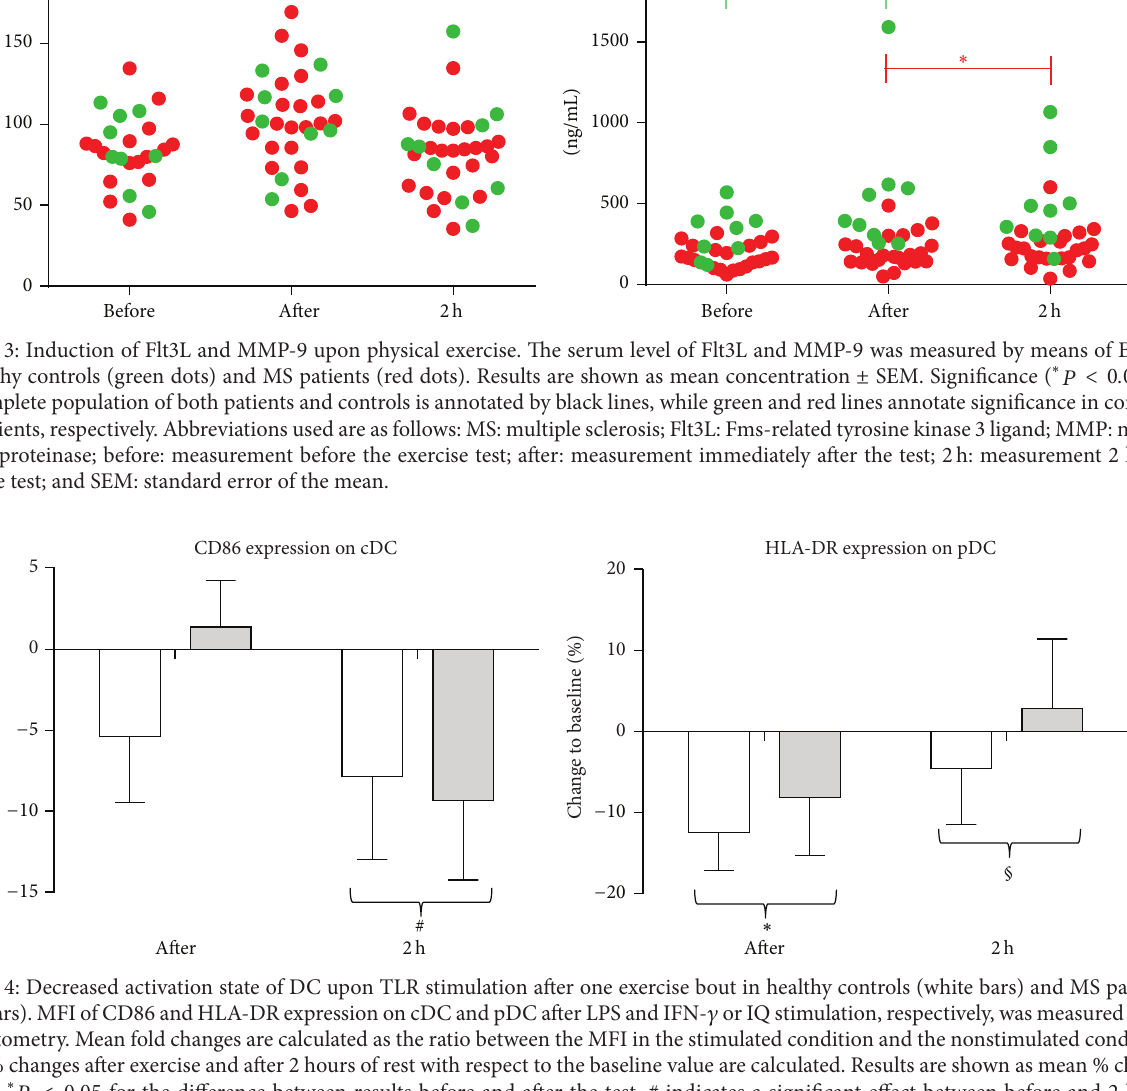
§ ∗ 2 h Figure 4: Decreased activation state of DC upon TLR stimulation after one exercise bout in healthy controls (white bars) and MS patients (grey bars). MFI of CD86 and HLA-DR expression on cDC and pDC after LPS and IFN- 𝛾 or IQ stimulation, respectively, was measured using flow cytometry. Mean fold changes are calculated as the ratio between the MFI in the stimulated condition and the nonstimulated condition. Then, % changes after exercise and after 2 hours of rest with respect to the baseline value are calculated. Results are shown as mean % change ± SEM. ∗ 𝑃 < 0.05 for the difference between results before and after the test. # indicates a significant effect between before and 2 hours after the test. § indicates a significant effect between after and 2 hours after the test. Abbreviations used are as follows: cDC: conventional dendritic cells; pDC: plasmacytoid dendritic cells; LPS: lipopolysaccharide; IFN: interferon; IQ: imiquimod; HLA: human leukocyte antigen; MFI: mean fluorescence intensity; after: measurement immediately after the test; 2h: measurement 2 hours after the test; and SEM: standard error of the